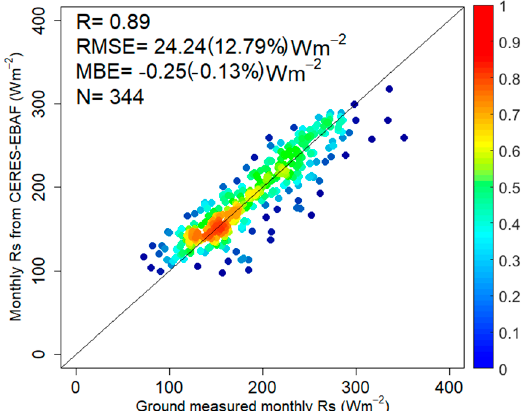
Figure 8. Evaluation results of monthly mean estimated R S data from CERES–EBAF data against ground measurements from CDC/CMA from February to May 2016. N is the number of data points.